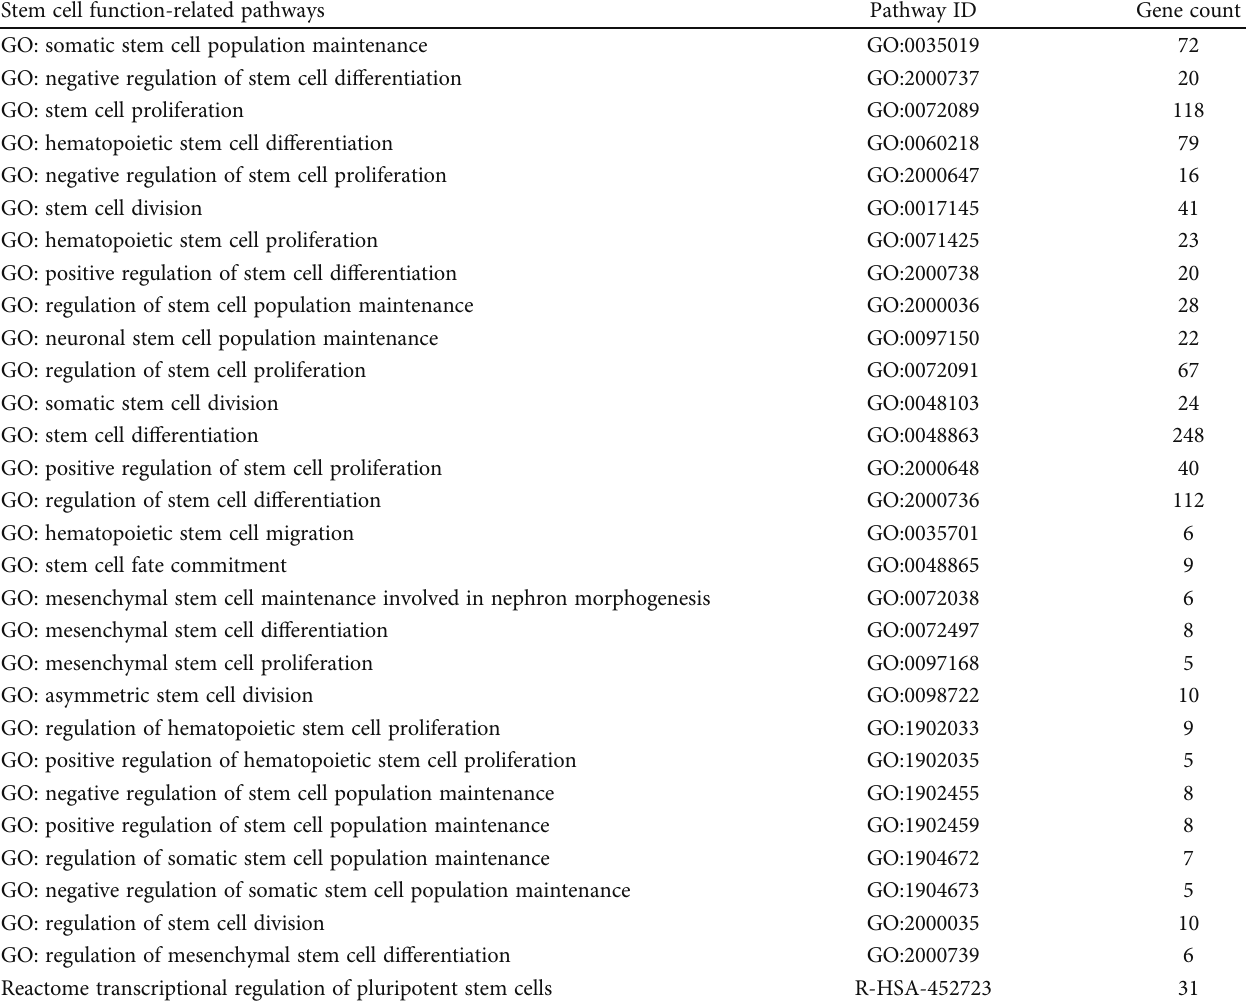
Table 2: Pathways related to CSCs in Reactome and GO